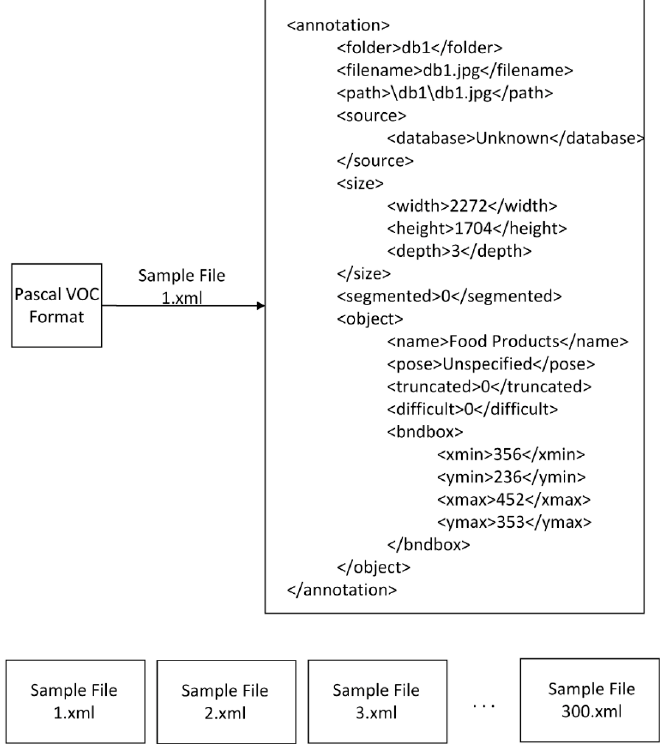
Figure 8. Structure of Pascal visual object classes (VOC) format for a sample file.